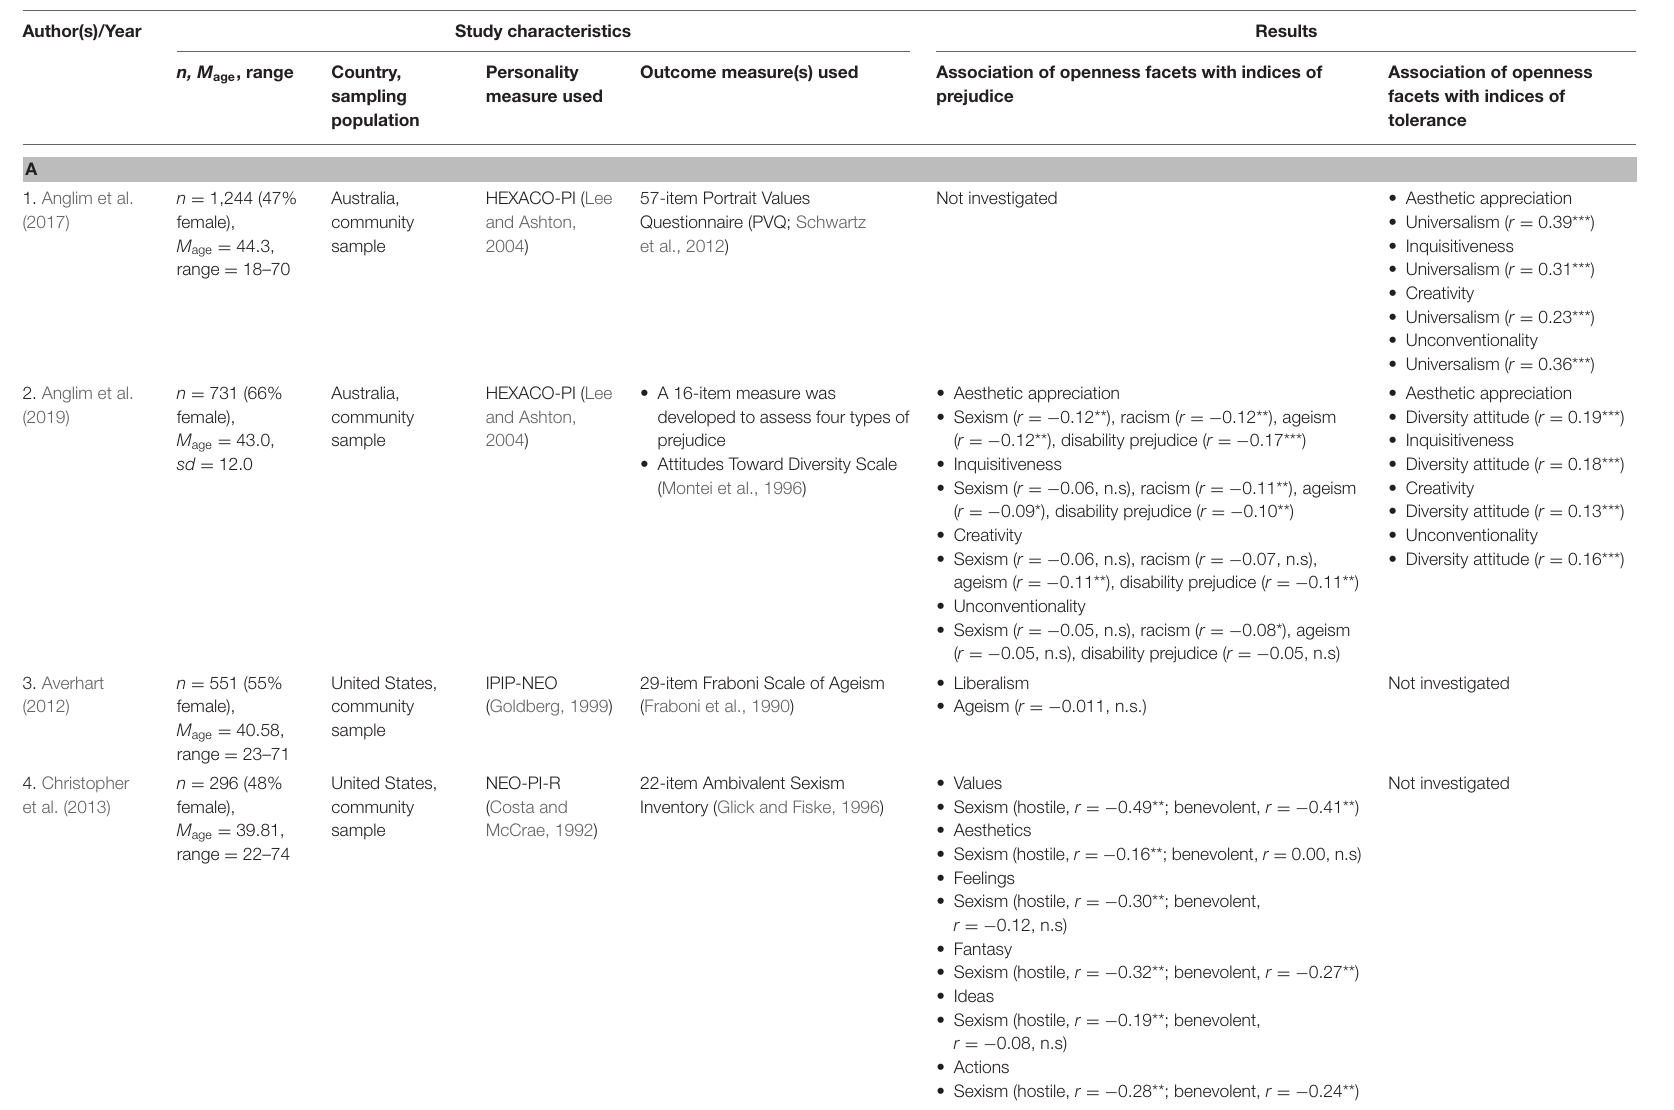
TABLE 2 | Study characteristics, sample demographics, and measures used in the 16 included articles.